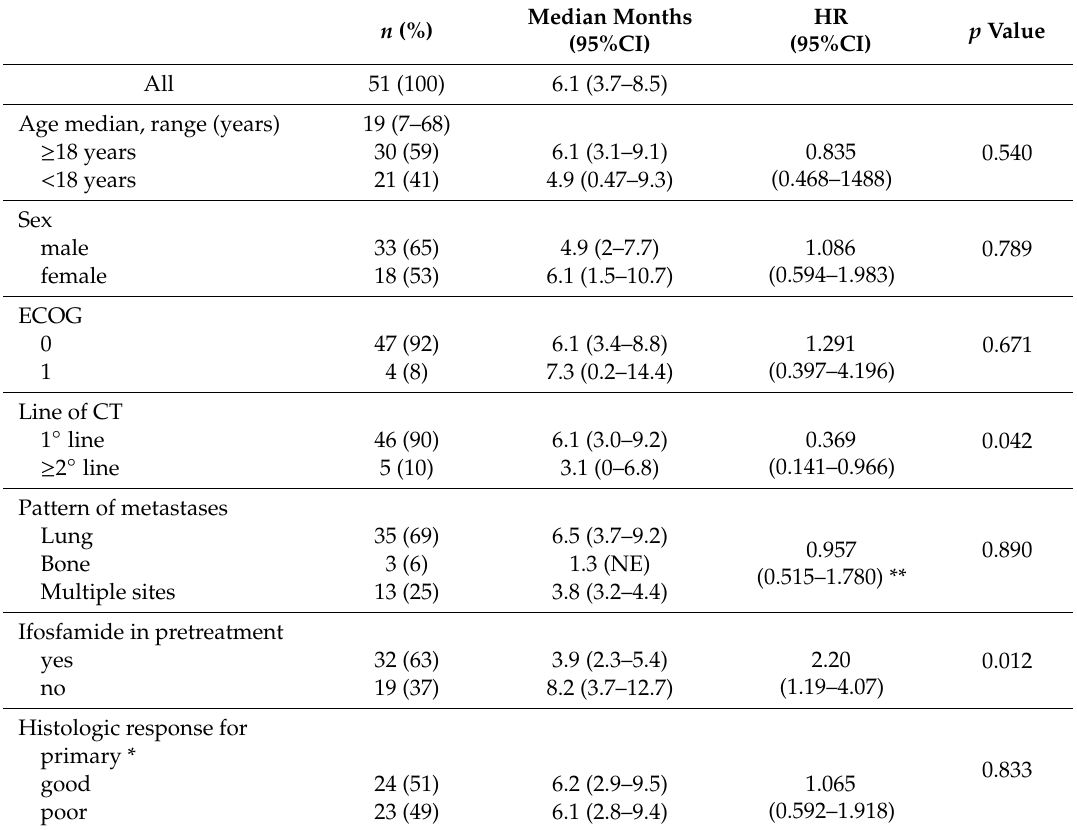
Figure 1. ( A ) Progression-free survival (PFS) in 51 patients treated with high dose ifosfamide; ( B ) PFS according with prior use of ifosfamide standard dose in the adjuvant setting. Table 4. Univariate analysis for progression-free survival (PFS) from HDIFO start in patients a ff ected by relapsed